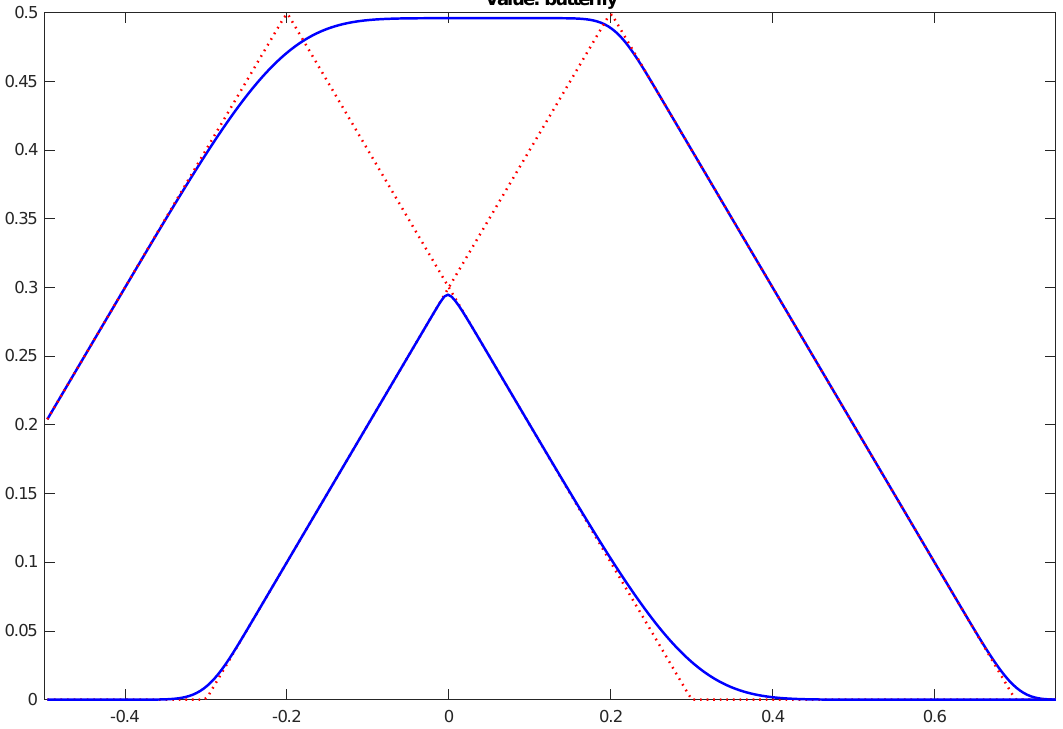
Figure 1. This figure shows the solution of the nonlinear PDE in Equation (14) with boundary condition ψ ( y ) = ( y − K 1 + x ) + − 2 ( y − K 2 + x ) + + ( y − K 3 + x ) + , K 1 = − 0.2, K 2 = 0.3, K 3 = 0.8, and x ∈ [ − 0.5,0.7 ] is depicted on the x-axis of the plot. The dashed lines show the solution for the lower bound (upper bound, respectively), i.e., for the constants λ = 0.1 and λ = 0.5. The upper and lower solid lines show the upper and lower price